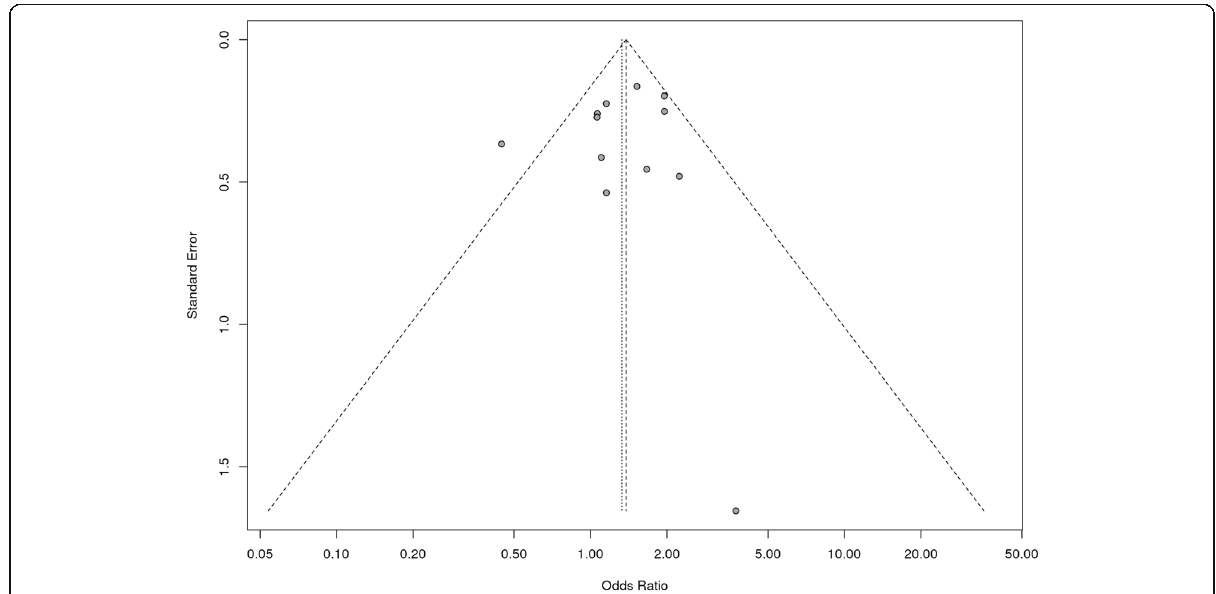
Fig. 4 Funnel plot for APOE gene polymorphism and CAD risk for ε 2